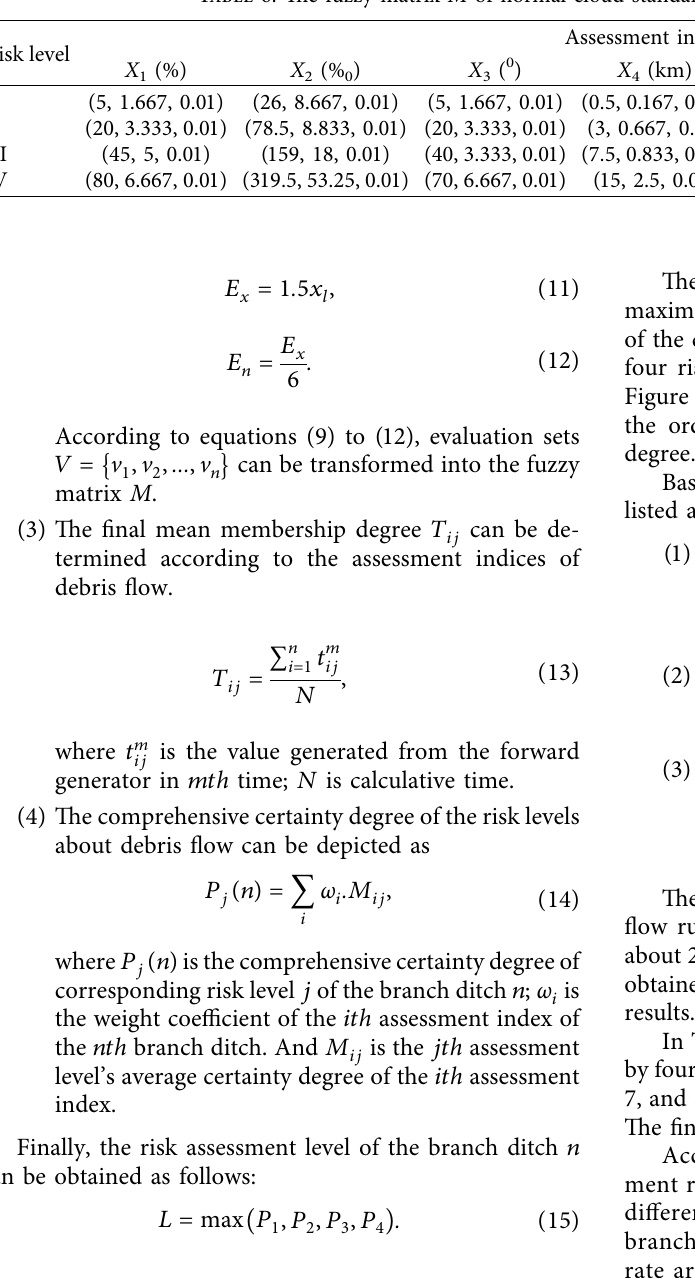
Table 6: The fuzzy matrix M of normal cloud standard classification about debris